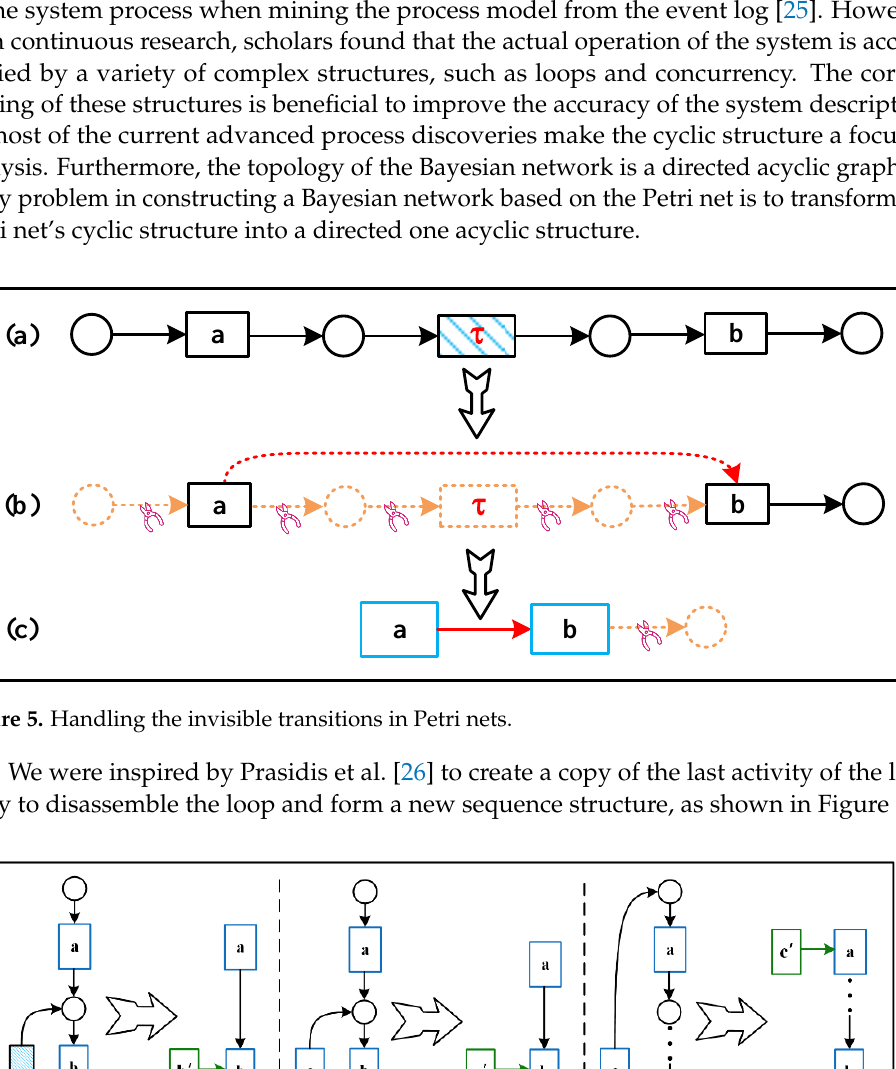
b Figure 4. Petri net simple structure converted to DAG.